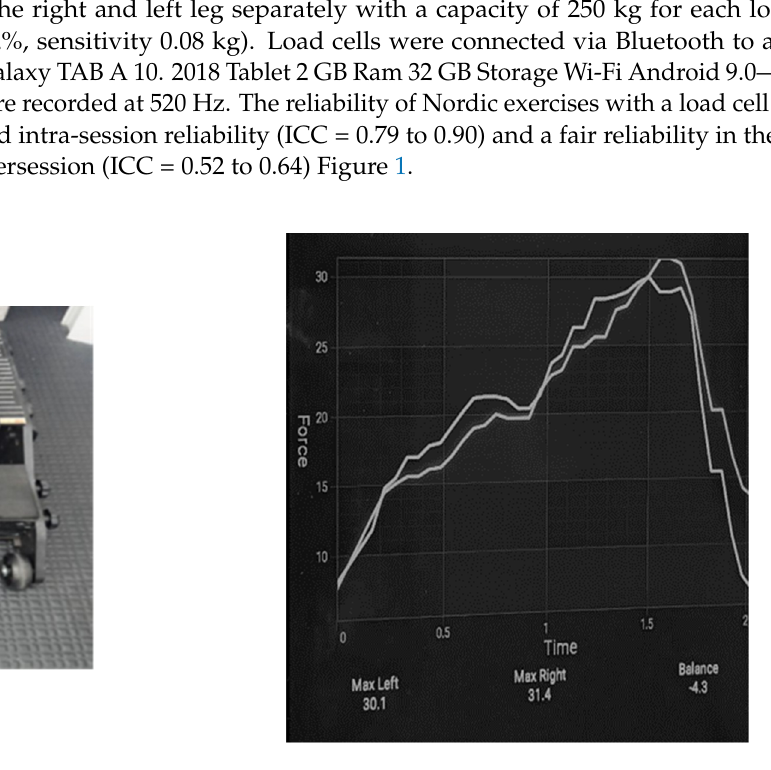
Figure 1. Illustration of the load cell device and the real-time visual display of peak hamstring strength (N) and bilateral strength balance (%) values.